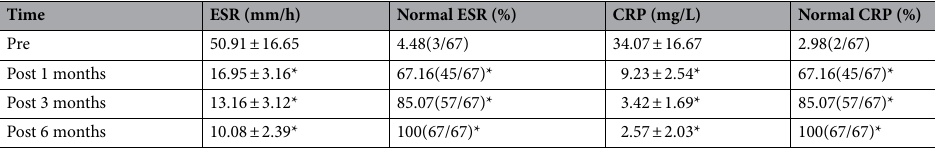
Table 1. Changes of ESR and CRP before and after the operation. *, compare with preoperation P < 0.05. ESR erythrocyte sedimentation rate, CRP C-reactive protein, Pre preoperative, Post postoperative.